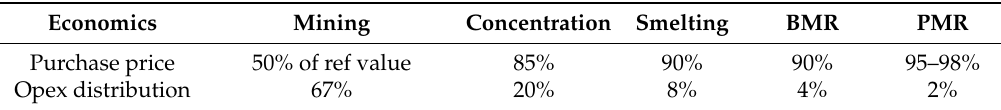
Table 1. Value chain for PGM processing (adapted from Ndlovu [11]). Economics